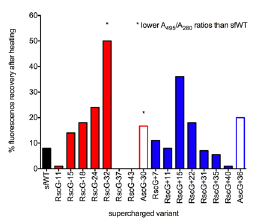
Figure 10 . Percent recovery of fluorescence after heating GFP variants to 95 6 C for 3 minutes . All variants were tested at 2 m M concentration. Some variants demonstrated poor A 495 /A 280 ratios and should not be directly compared to sfWT (RscG 2 32 and AscG 2 30). Improvements to refolding are 3-fold for RscG 2 24 and 4.5-fold for RscG +